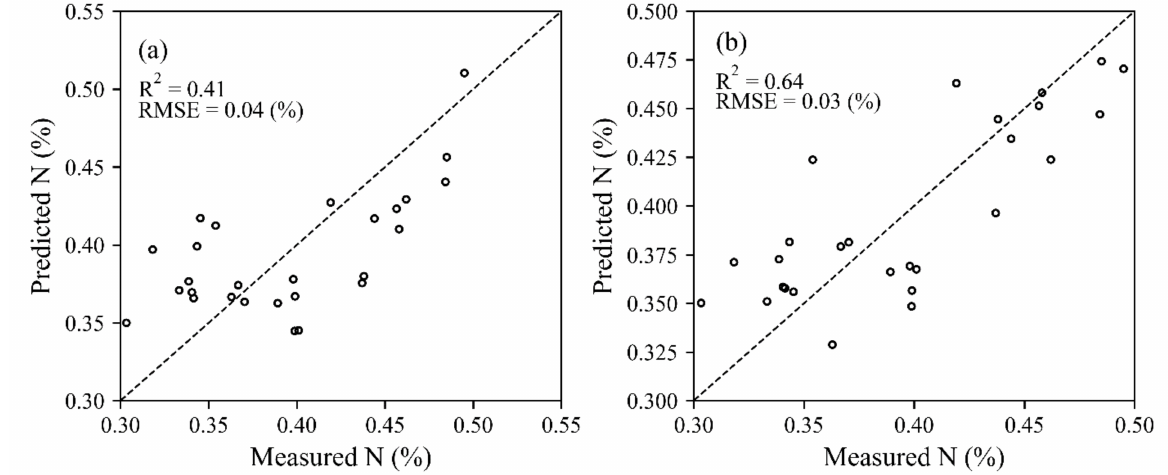
Figure 9. Relationships between the measured and estimated N concentration at the plant-level. The estimated values were obtained using ( a ) CI red edge and ( b )